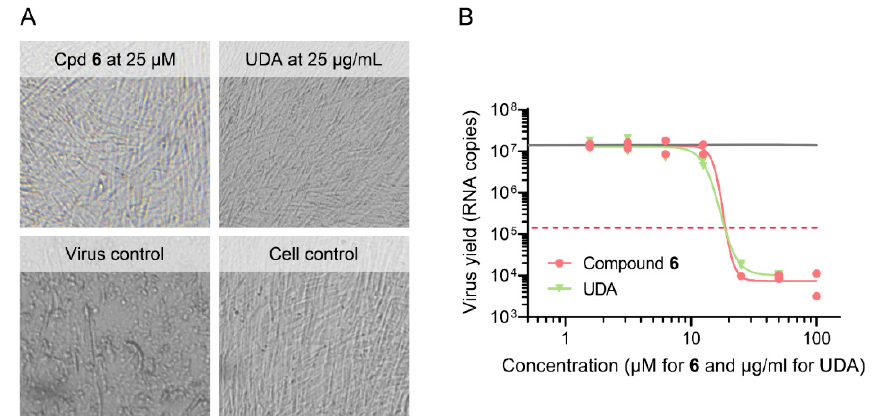
Figure 2. Activity of compound 6 in human embryonic lung (HEL) cells infected with human coronavirus 229E. ( A ) Representative images showing complete inhibition of viral CPE at non-toxic compound concentrations (reference compound: UDA lectin). ( B ) Reduction in virus yield, as determined by RT-qPCR for viral RNA in the supernatant at day 4 p.i. (lower limit of detection: 10 2 copies). Curve fitting by GraphPad Prism, on two data points from one experiment performed in duplicate. Full grey line: virus yield for untreated virus control; red dashed line: 100-fold reduction in virus yield. Table 3. Evaluation of compounds 6 and 7 against a broad range of DNA- and RNA-viruses 1 . Compound